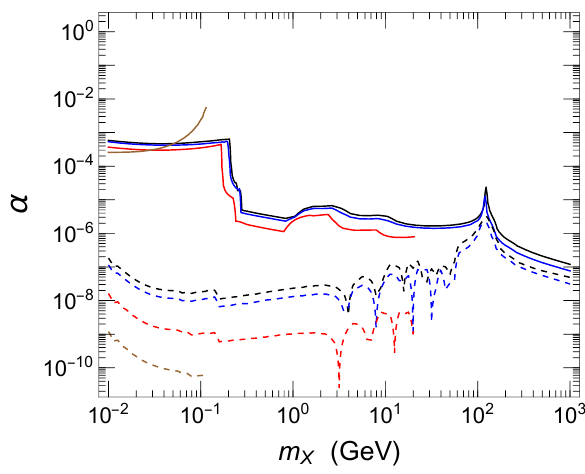
Figure 3 . (a) The solid lines show the lower bound of α about keeping the hidden sector in temperature equilibrium with the thermal bath before freeze-out, assuming that the hidden sector particles follow the equilibrium density distributions; see the discussions in section 3. (b) The dashed lines show the minimum values of α above that Y X,S grow by up to Y eq ( T ) at T with T & m X ; X,S see eq. (4.10) and its related discussions. From up to bottom at m X = 0 . 02 GeV the lines (with colors black, blue, red, and brown) correspond to r (= m S /m X ) = 1 . 01 , 1 . 05 , 1 . 25 , 1 . 5 ,